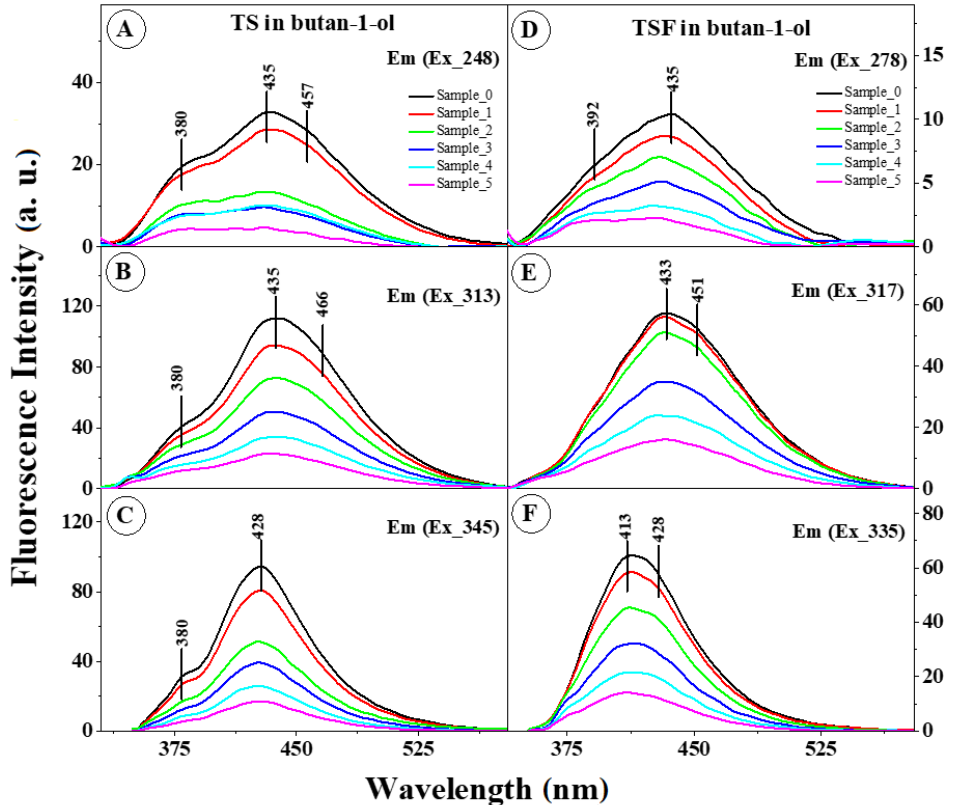
Figure 7. Fluorescence emission spectra of TS and TSF dissolved in butan-1-ol. For TS: ( A ) excitation at 284 nm; ( B ) excitation at 313 nm; and ( C ) excitation at 345 nm. For TSF: ( D ) excitation at 278 nm; ( E ) excitation at 317 nm; and ( F ) excitation at 335 nm. Measurements were carried out for six different dilutions: sample 0: 3 mg of TS/TSF dissolved in 2 mL of butan-1-ol; sample 1: sample 0 + 1 mL of butan-1-ol; sample 2: sample 1 abstract 1 mL + 1 mL of butan-1-ol; sample 3: sample 2 abstract 1 mL +